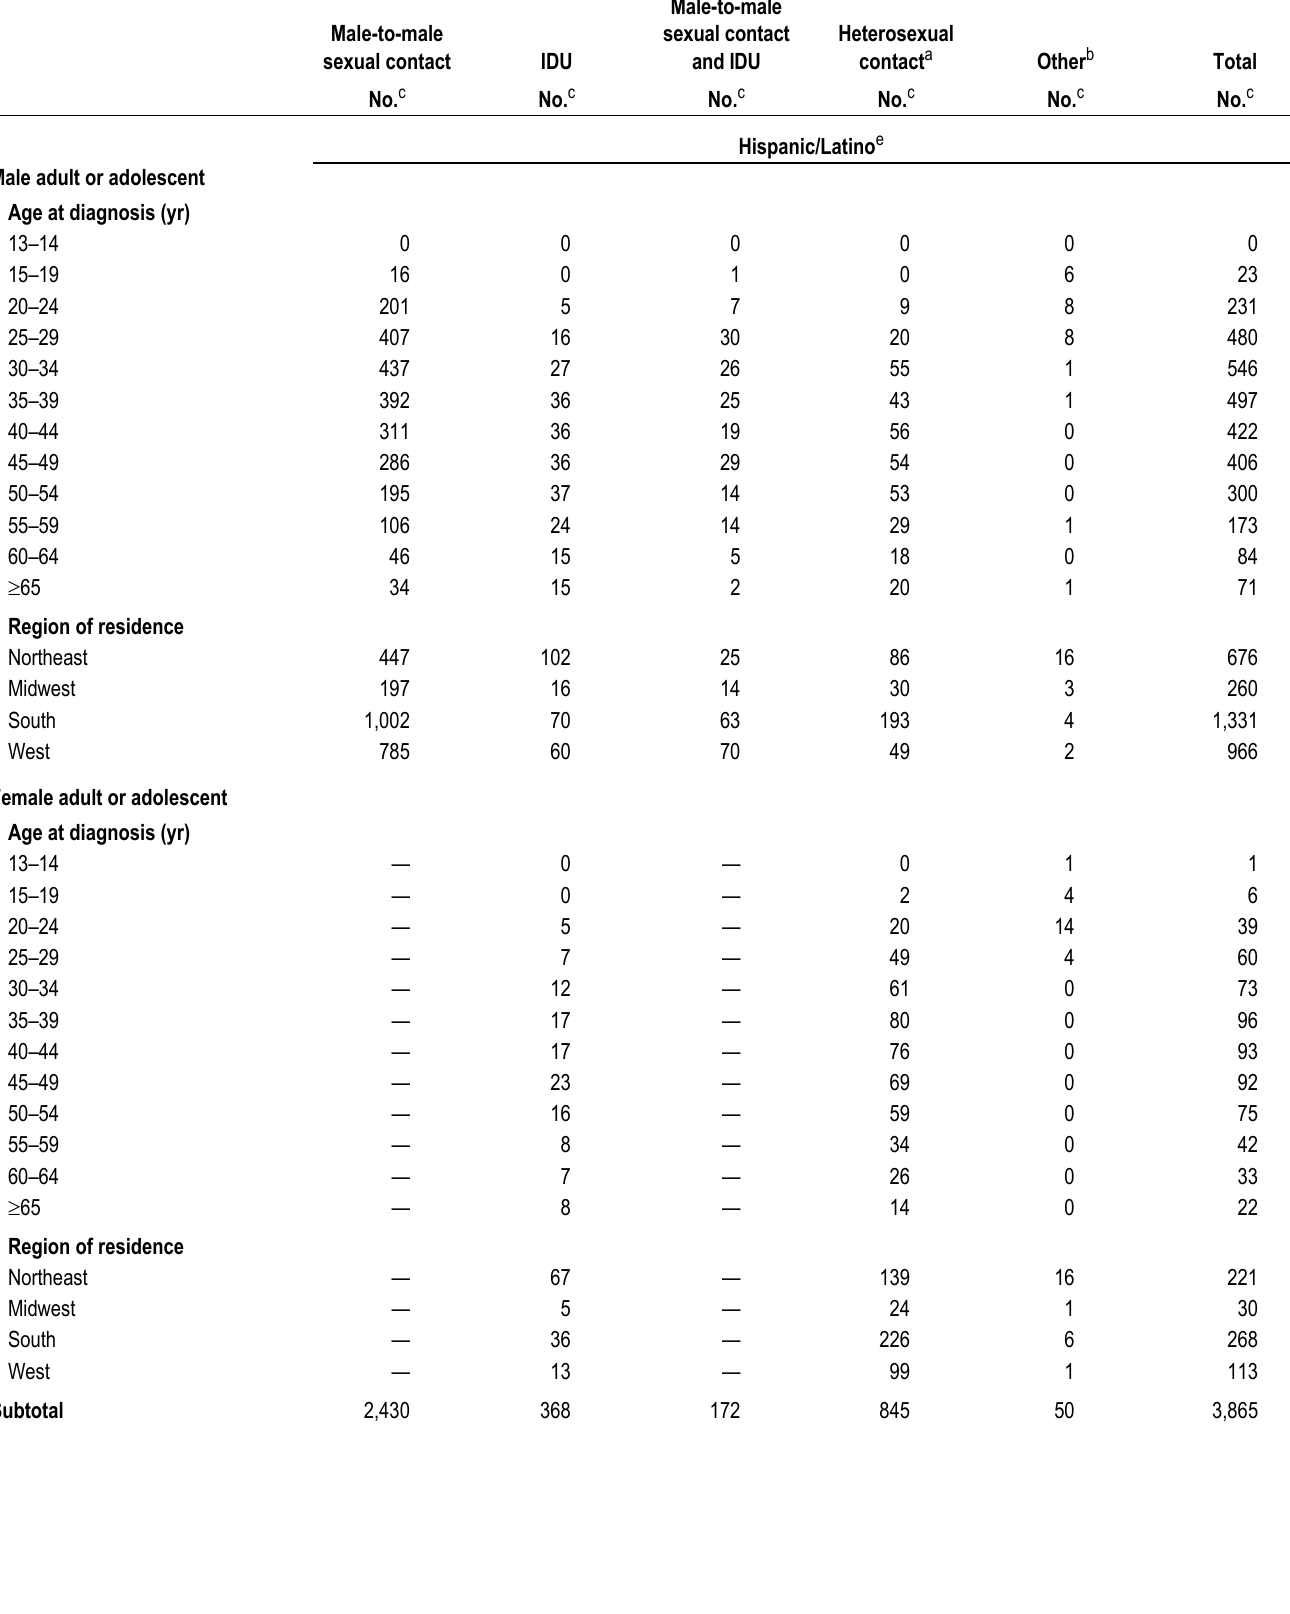
Table 6a. Stage 3 (AIDS), by transmission category, race/ethnicity, and selected characteristics, 2015—United States